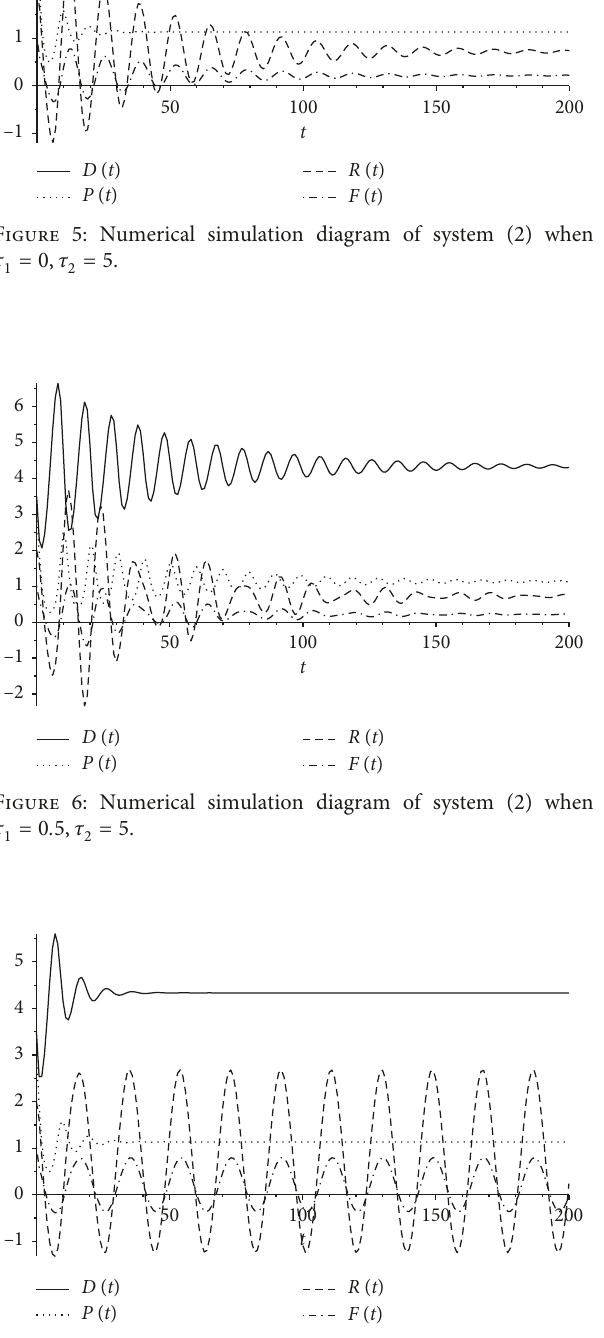
Figure 7: Numerical simulation diagram of system (2) when � 0 , τ � 7 . τ 1 2